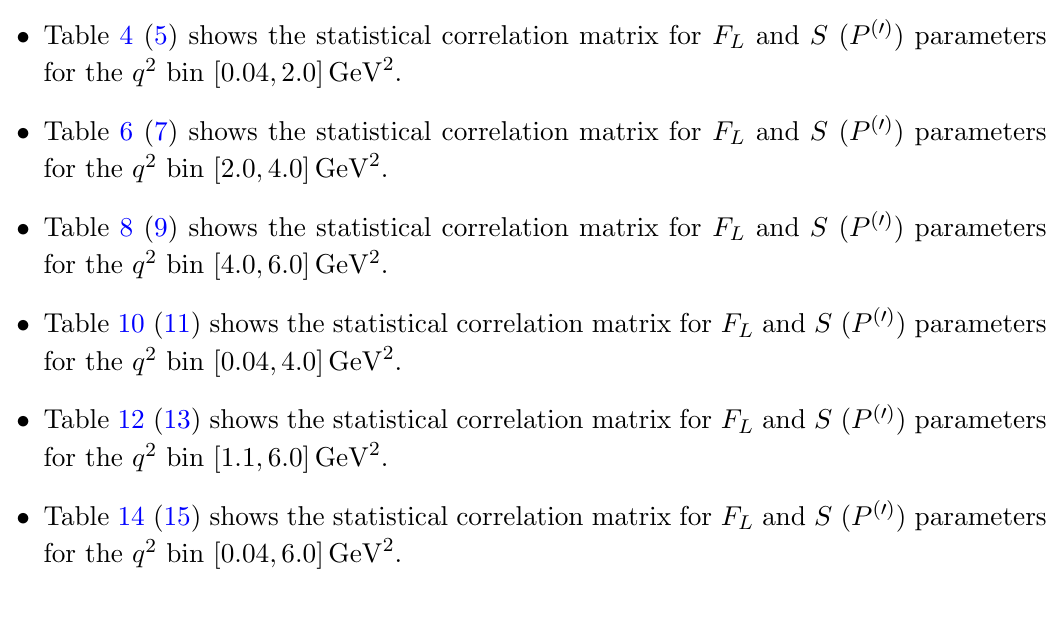
parameters L and S ( P ( 0 ) )